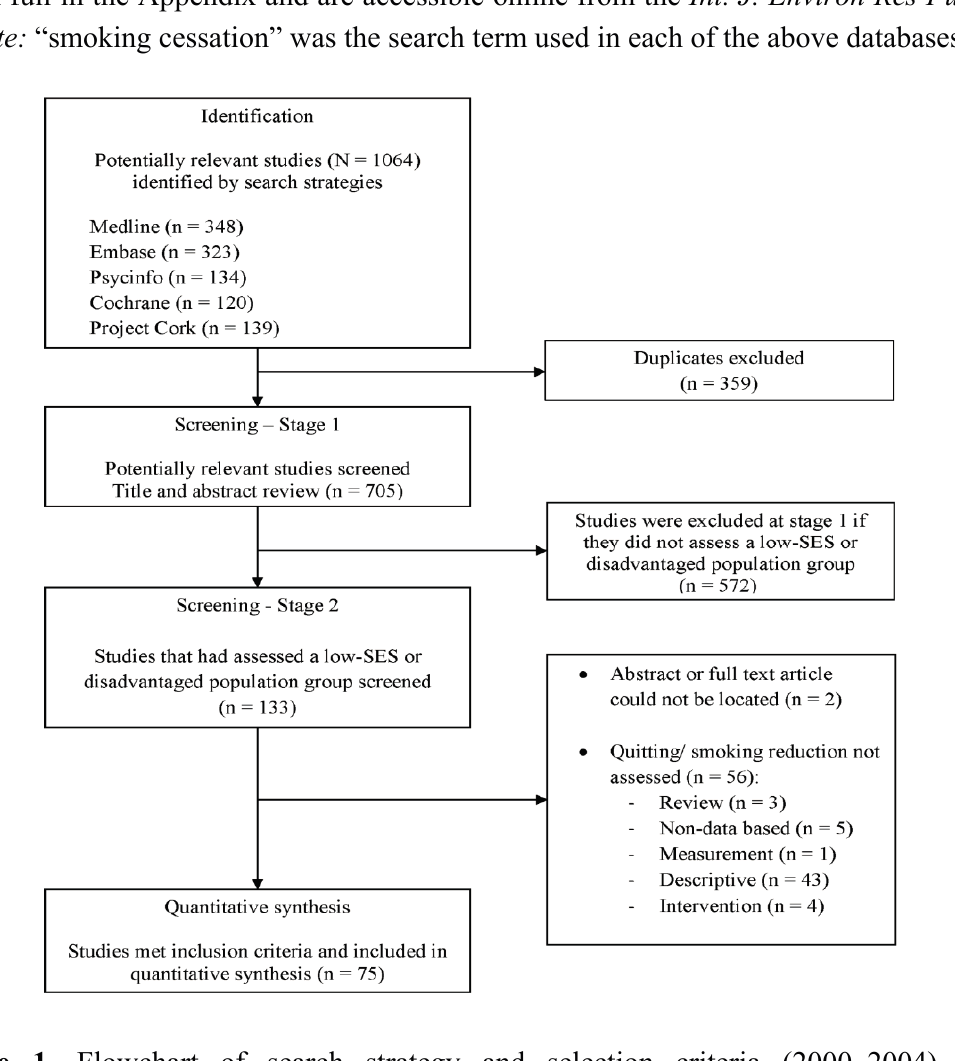
Figure 1. Flowchart of search strategy and selection criteria (2000–2004) using PRISMA